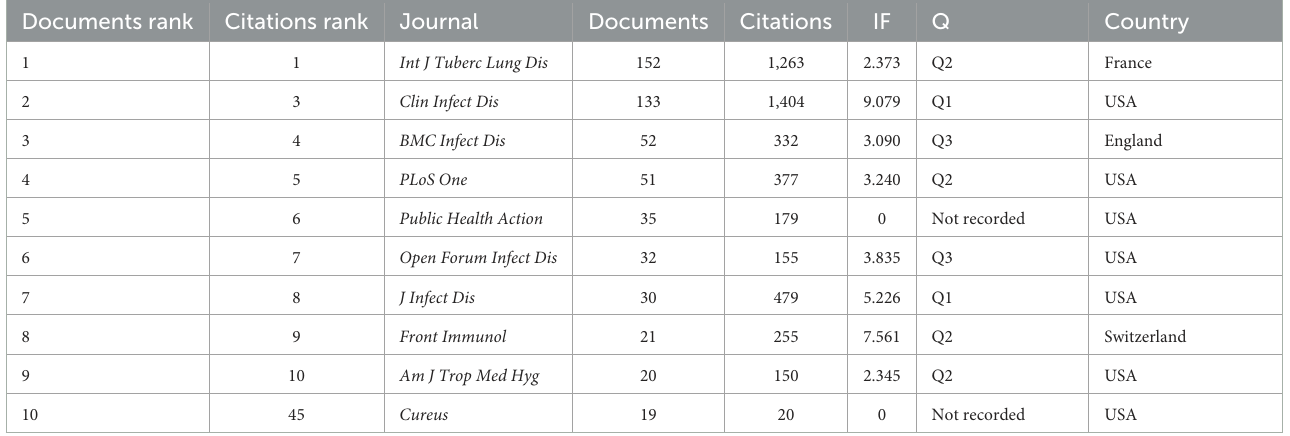
TABLE 3 The top 10 journals and co-cited journals about HIV-MTB